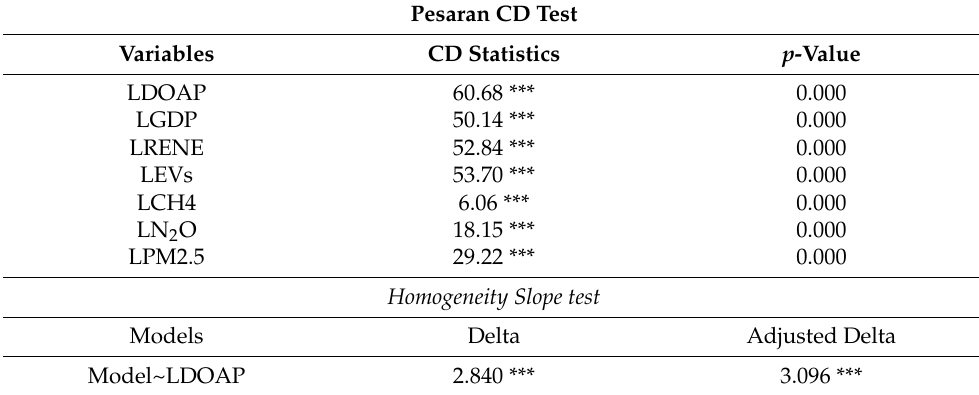
Table 6. Pesaran CD and homogeneity slope tests.